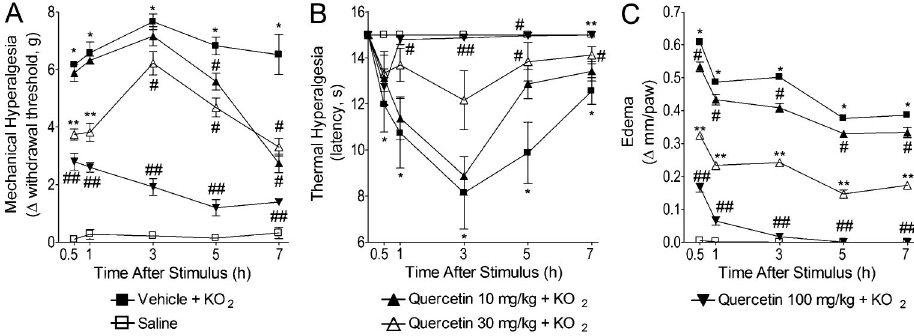
Figure 6. Quercetin inhibited the KO 2 -induced mechanical hyperalgesia ( A ), thermal hyperalgesia ( B ), and edema ( C ) in a dose- dependent manner. Mice were treated with quercetin (10-100 mg/kg, ip ) or vehicle (20% tween 80 in saline, 150 m L, ip ) 1 h before KO 2 (30 m g/paw) or saline injection. Data are reported as means±SE. *P , 0.05 vs saline control; # P , 0.05 vs KO 2 control; **P , 0.05 vs 10 mg/kg; ## P , 0.05 vs 30 mg/kg (one-way ANOVA followed by Tukey’s t -test). of paw flinching (Figure 7A), paw licking (Figure 7B), and abdominal writhing (Figure 7C). Quercetin also inhibited KO 2 -induced recruitment of total leukocytes (Figure 8A), mononuclear cells (Figure 8B), and neutrophils (Figure 8C) to the peritoneal cavity of the mice. The ipl injection of KO 2 induced diminished ABTS (Figure 9A), FRAP (Figure 9B), and GSH levels (Figure 9C) in plantar skin samples. Quercetin inhibited a KO 2 - induced decrease in ABTS (Figure 9A), as well as FRAP (Figure 9B) and GSH levels.